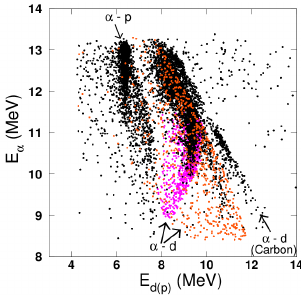
Figure 1. E α -E d ( p ) correlation plot for the α -particles detected in MAGNEX in coincidence with deuterons (protons) detected in the detector mounted at θ lab ∼ 5 o at the beam energy of 25 MeV (See text for details). Data are also reported in Ref.[6, 7].